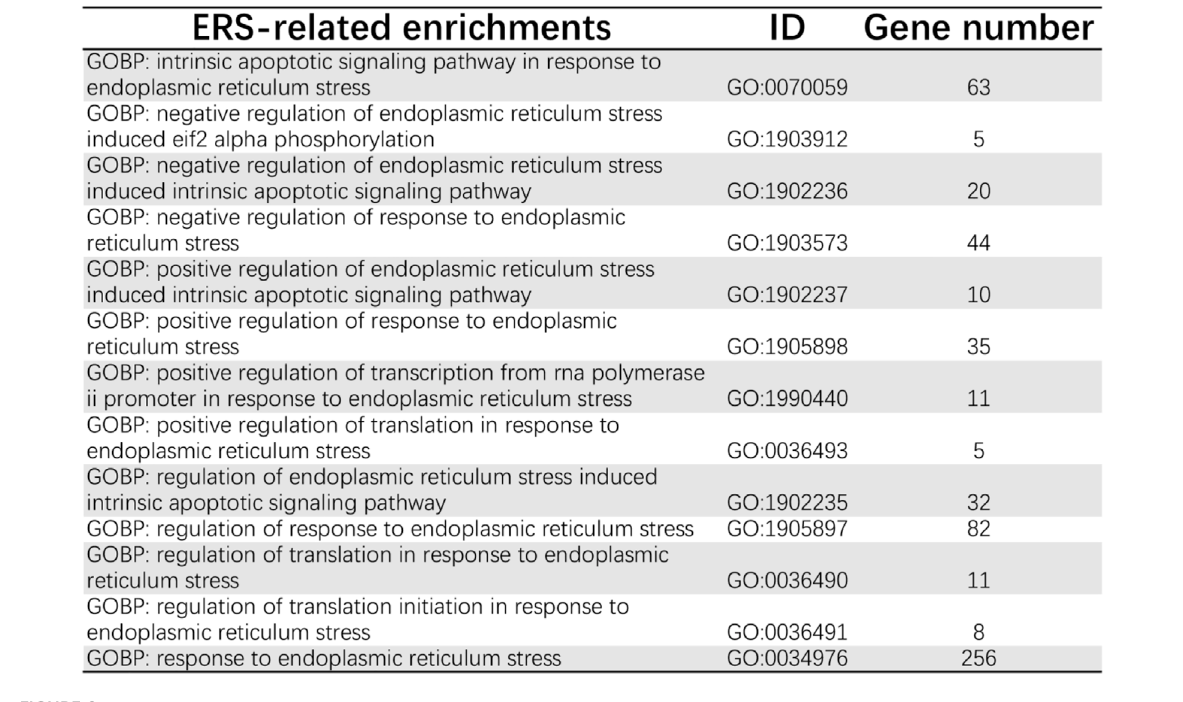
FIGURE 2 ER stress-related pathways from